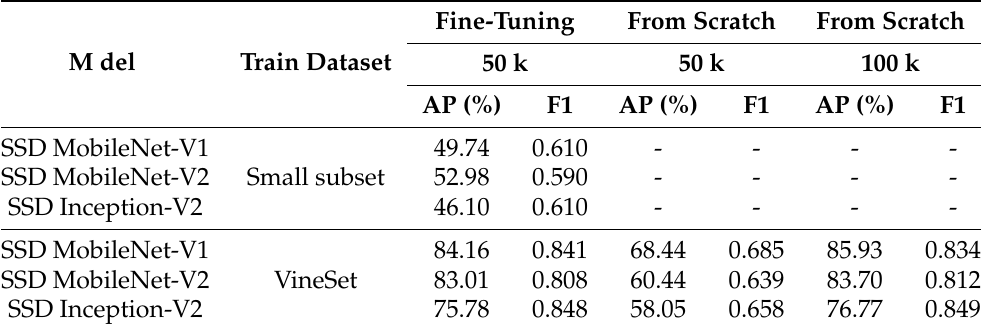
Table 4. AP (%) and F1 Scores of the trained models. The three models were trained while using a small subset of the VineSet, and VineSet itself. In addition, using VineSet, three experiments were performed for each model. The performance of each one was compared using Transfer Learning (by fine-tuning) and training them from scratch with two different numbers of training epochs.